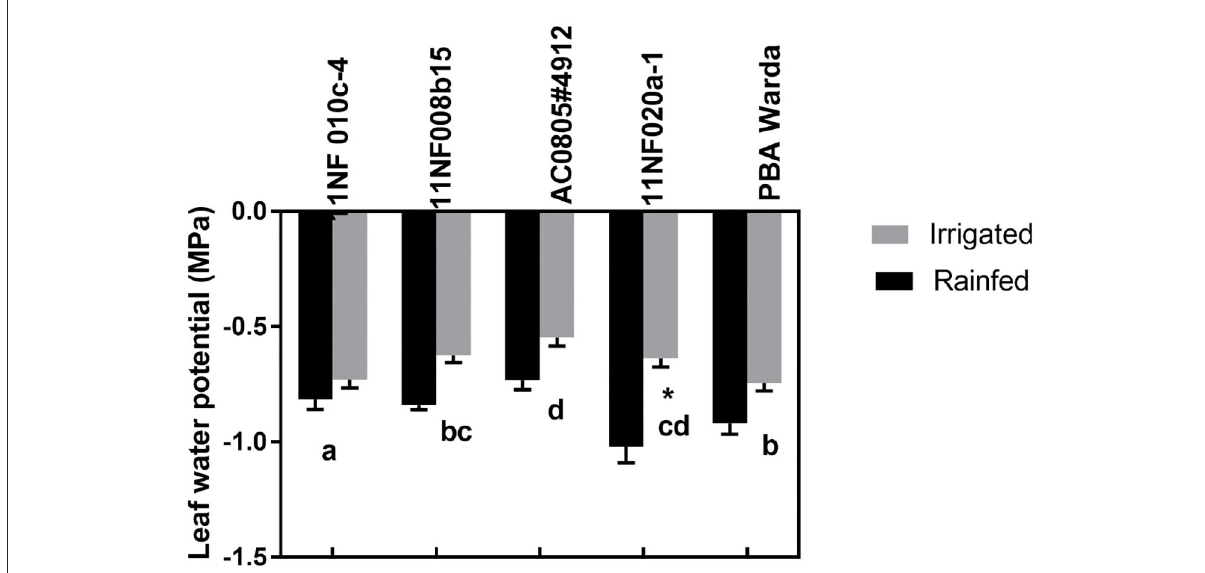
FIGURE2 Predawn leaf water potentials (MPa) of contrasting faba bean genotypes at the three-pod stage grown under field condition (irrigated and rainfed trial) at Narrabri, Australia. Error bars were calculated from four replicates and represent standard error of the mean. Letters represents a significant difference ( p < 0.05) among genotypes calculated through DMRT. Asterisks (*) represent significance between irrigated and rainfed treatments.